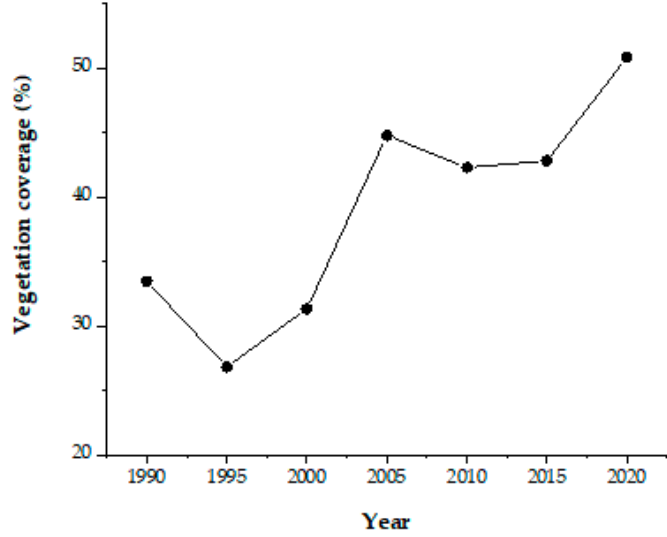
Figure 8. Vegetation coverage in Baotou City from 1990 to 2020.